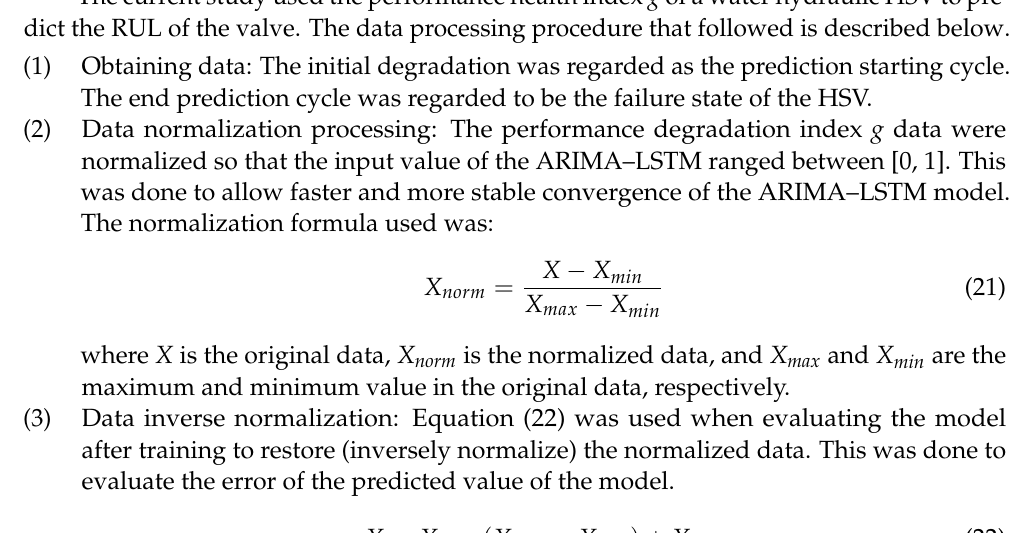
Figure 10. Confusion matrix of prediction and true states.